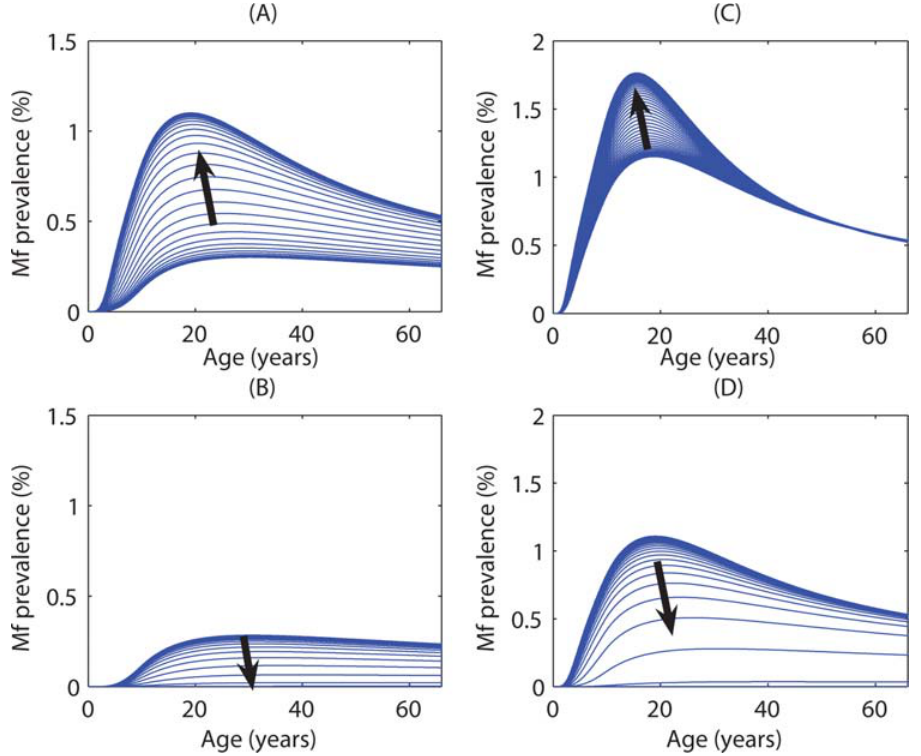
Figure 3. The direction of change of the Mf prevalence age-profile among human hosts when the intermediate host was culicine and the initial Mf prevalence was (A) above and (B) below the breakpoint value (0.21%) with a vector biting rate of 11 per month; and when the intermediate host was anopheline with initial Mf prevalence (C) above and (D) below the breakpoint value (0.82%) with a vector biting rate of 280 per month. Each age-dependent curve represents a perturbation around the initial unstable equilibrium curve with the black arrows indicating the direction in which these curves are likely to travel on the way to the stable equilibrium.